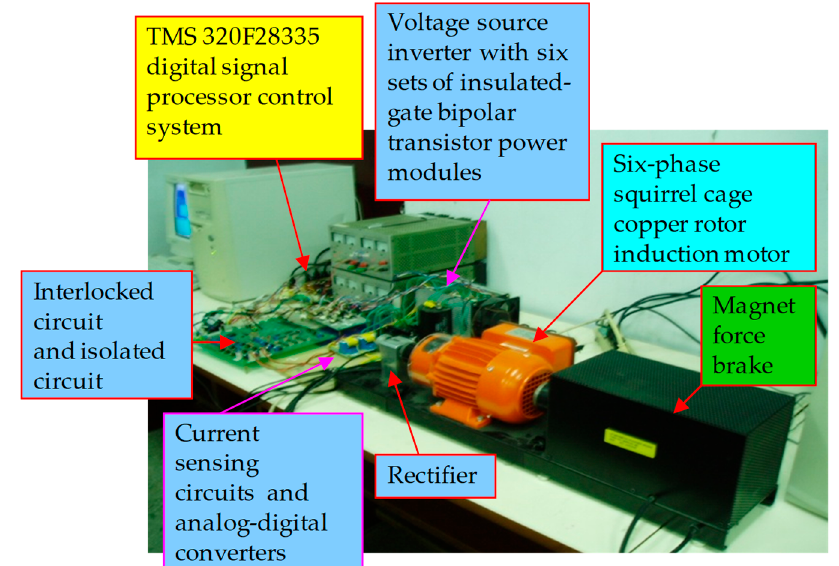
Figure 6. A photo picture of the examined structure.